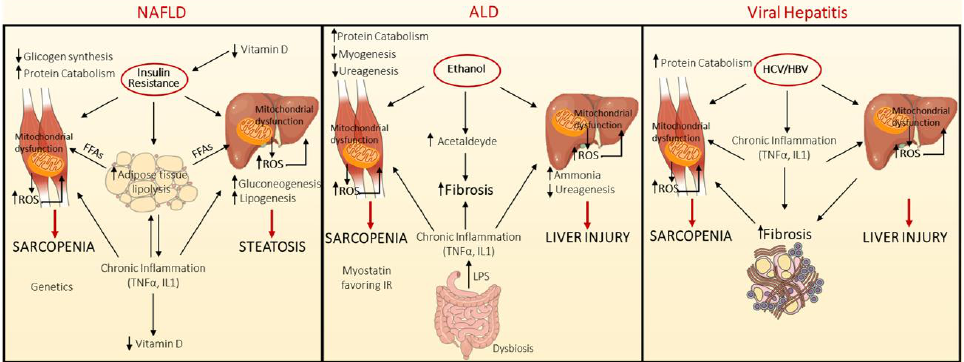
Figure 1. Pathogenic mechanisms linking sarcopenia development in the context of non-alcoholic Fatty Liver Disease (NAFLD), Alcoholic Liver Disease (ALD) and Viral hepatitis. NAFLD and sarcopenia share common underlying pathogenic mechanisms, such as IR, chronic inflammation, mitochondrial dysfunction, nutritional deficiencies, and reduction in physical activity. In the context of NAFLD, the key pathogenic event is the presence of insulin resistance (IR), which is associated with compensatory hyperinsulinemia. Insulin plays a primary role in different tissues among which liver, adipose tissue and muscle. IR in adipose tissue triggers the activation of lipolysis, favouring in turn the release of free fatty acids (FFAs) into the bloodstream. At the hepatic level, the reduced insulin signalling hampers the phosphorylation of Forkhead box O1-phosphorylated (FOXO1), whereby forcing gluconeogenesis, while the enhanced influx of FFAs induces fat deposition, endoplasmic reticulum (ER) stress, mitochondrial dysfunction, and reactive oxygen species (ROS) production. Moreover, hyperinsulinemia stimulates de novo lipogenesis, through sterol regulatory element- binding protein-1c (SREBP1c). In muscle tissue, IR suppresses glycogen synthesis and muscle mass enlargement. In addition, both sarcopenia and NAFLD are shaped by a chronic inflammation, characterized by tumour necrosis factor alpha (TNF α ) and interleukin 1 (IL1) over-secretion. Similarly, Vitamin D deficiency participates to sarcopenia onset. The gut microbiota and the somatotropic axis are involved both in sarcopenia and NAFLD, but their effect on sarcopenia development and progression in NAFLD is not well established ( left panel). Likewise, in Alcoholic Liver disease (ALD), ethanol exerts a detrimental effect on both muscle and liver, through its conversion into acetaldehyde, which induces ROS production, mitochondrial dysfunction, promotes the activation of hepatic stellate cells (HSCs) producing extracellular matrix (ECM) deposition, and interferes with hepatic ureagenesis with consequent increase in ammonia levels. Hyperammonaemia per se blunted protein synthesis in skeletal muscle and stimulates myostatin, a member of transforming growth factor beta (TGF β ) ( middle panel). Less is known regarding the mechanisms linking chronic viral hepatitis and sarcopenia. In this background, chronic inflammation promotes the protein catabolism in muscle cells, by ubiquitin-proteasome system (UPS) ( right